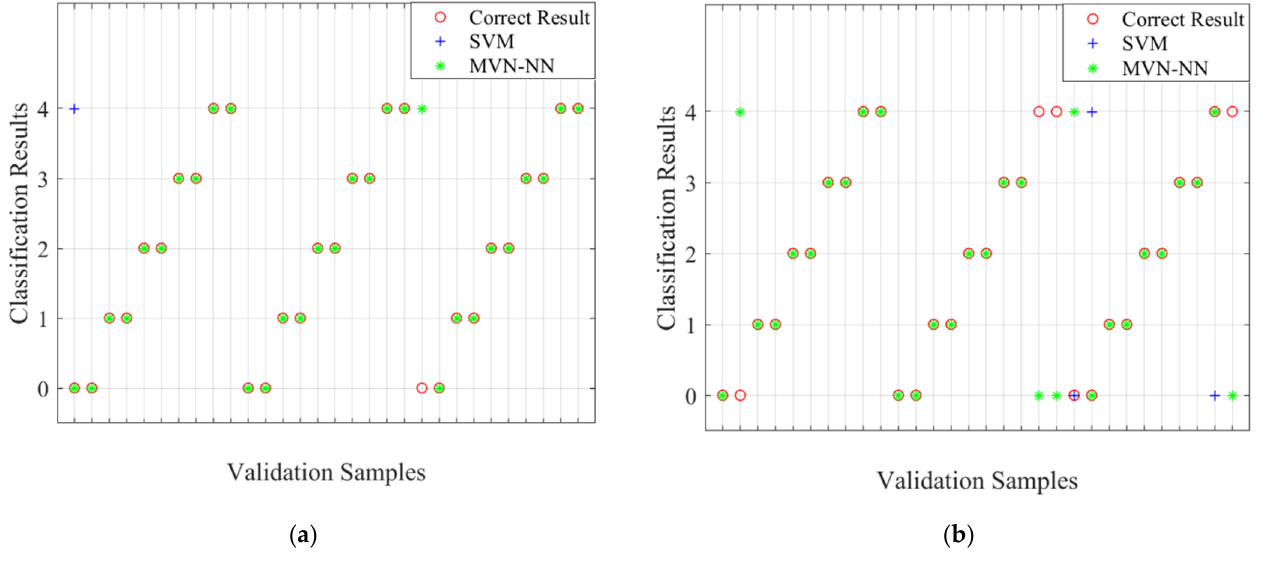
Figure 10. Comparison between MLMVN and SVM; ( a ) performance obtained by processing meas- urements under the same conditions of the training phase; ( b ) performance obtained by processing measurements with different irradiance and temperature values. Table 7. Simulation Results.